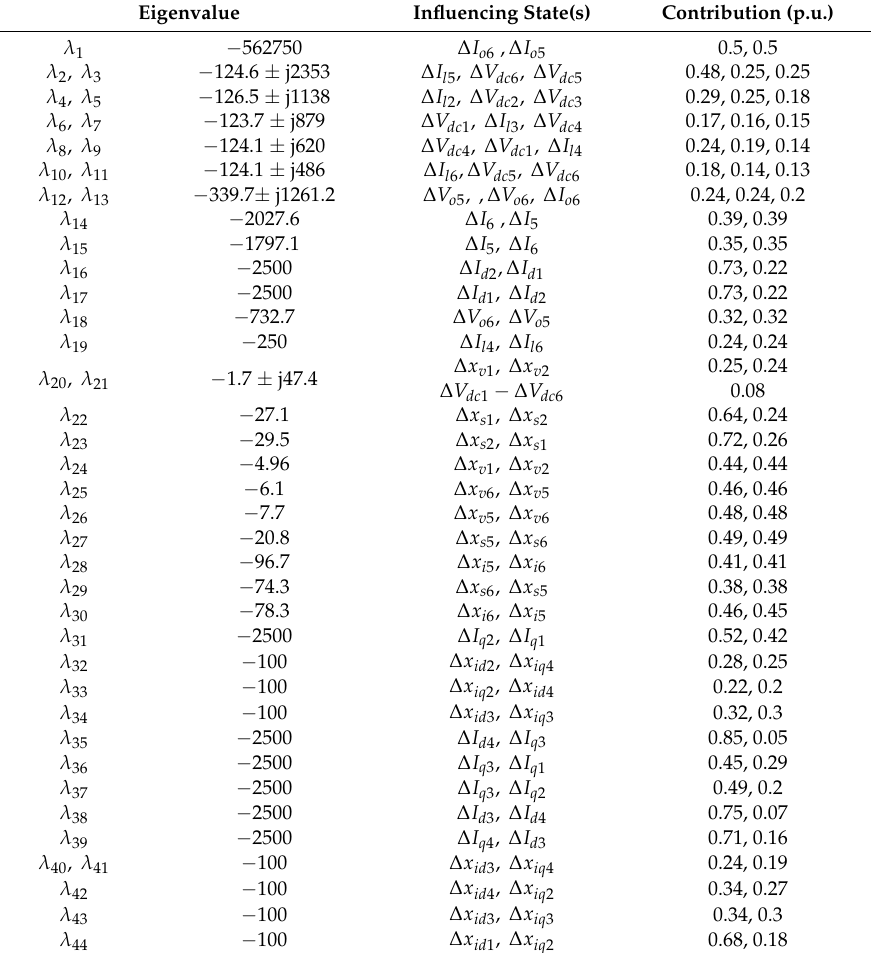
Figure 4. Time domain simulation of the dc power flowing through line 4 following the doubling of the MTDC lines inductance at t = 8 s. Table 1. Eigenvalues and Participation Factor Analysis of the MTDC System .